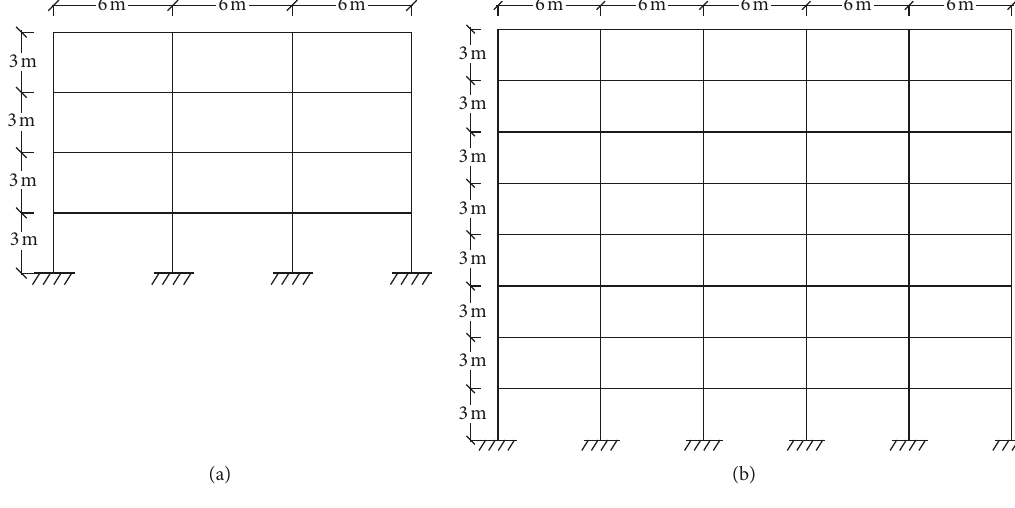
Figure 2: Structures to be optimized. (a) 4-story SMRF. (b) 8-story SMRF. Table 1: Sections for